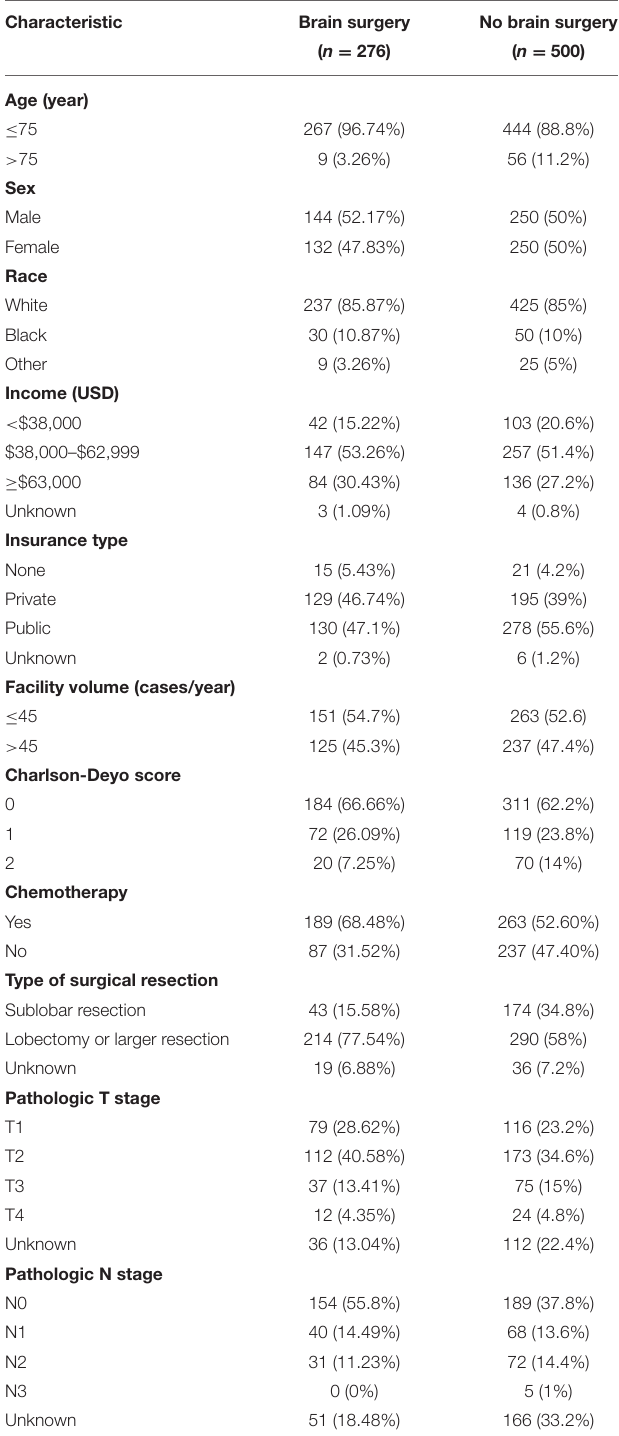
TABLE 2 | Demographic and clinical characteristics of the study